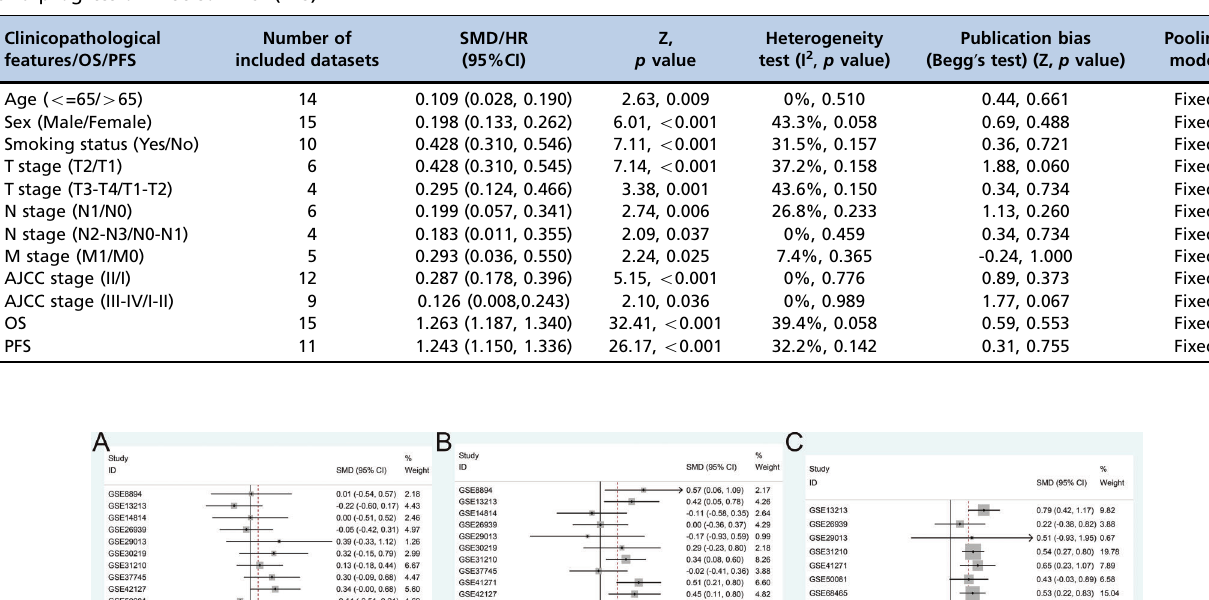
Table 3 - Main results and publication bias for the meta-analysis between BUB1B and clinicopathological features, overall survival (OS), and progression-free survival (PFS).